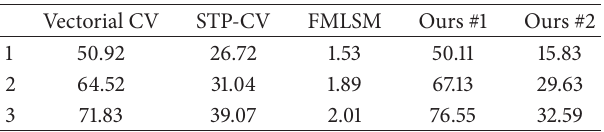
Table 1: The CPU time in second for the vectorial CV model traditional solution method, and the proposed model for the three synthetic images from Figure 4. The sizes of images are 240 × 110, 170 × 170, and 256 × 256,